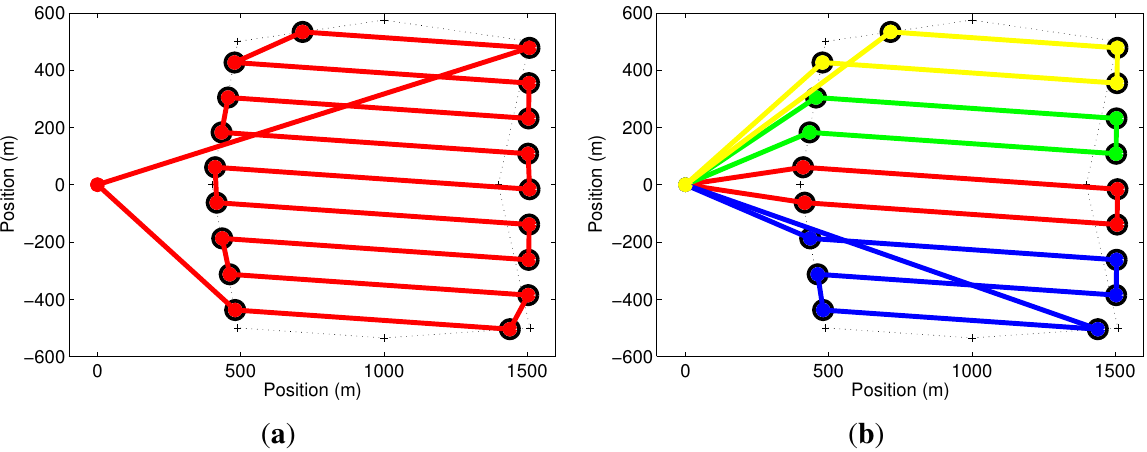
Figure 8. Two trivial solutions for the optimization problem. ( a ) The path for the only UAV available; ( b ) the paths for the four UAVs available when the setup time is not considered or each UAV has it is own operator (the setup time is noncumulative). In those cases, the area is simply divided among the available